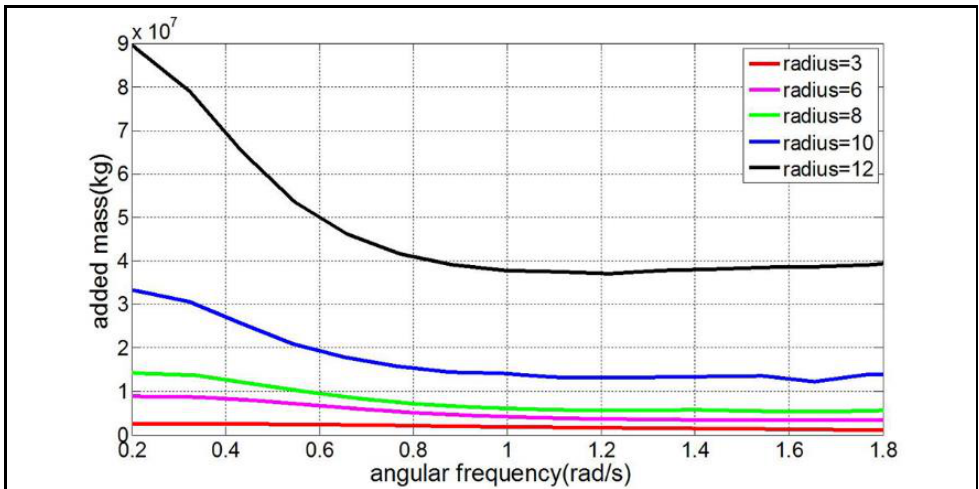
Figure 12. Diagram of added mass vs. base radius.